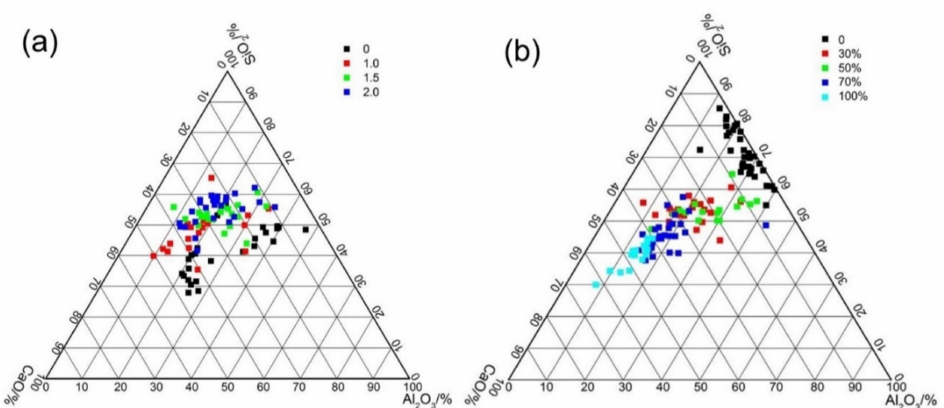
Figure 13. Al 2 O 3 –SiO 2 –CaO ternary representations of EDS data of the AAFS paste with di ff erent activator modulus (the slag content is 30 wt %) ( a ) and that with di ff erent slag content (the activator modulus is 1.5) ( b ) at